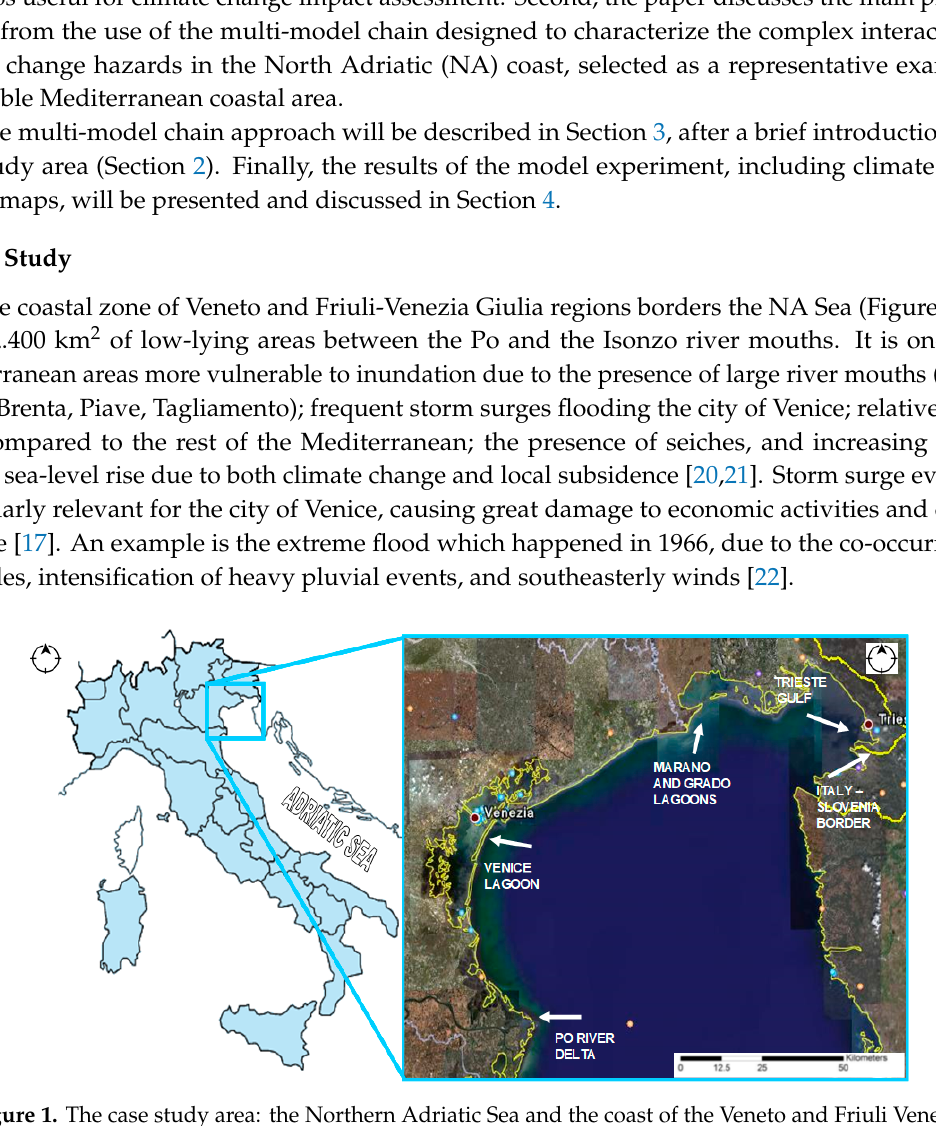
Figure 1. The case study area: the Northern Adriatic Sea and the coast of the Veneto and Friuli Venezia Giulia regions (Italy). (Adapted from google maps: maps.google.it).